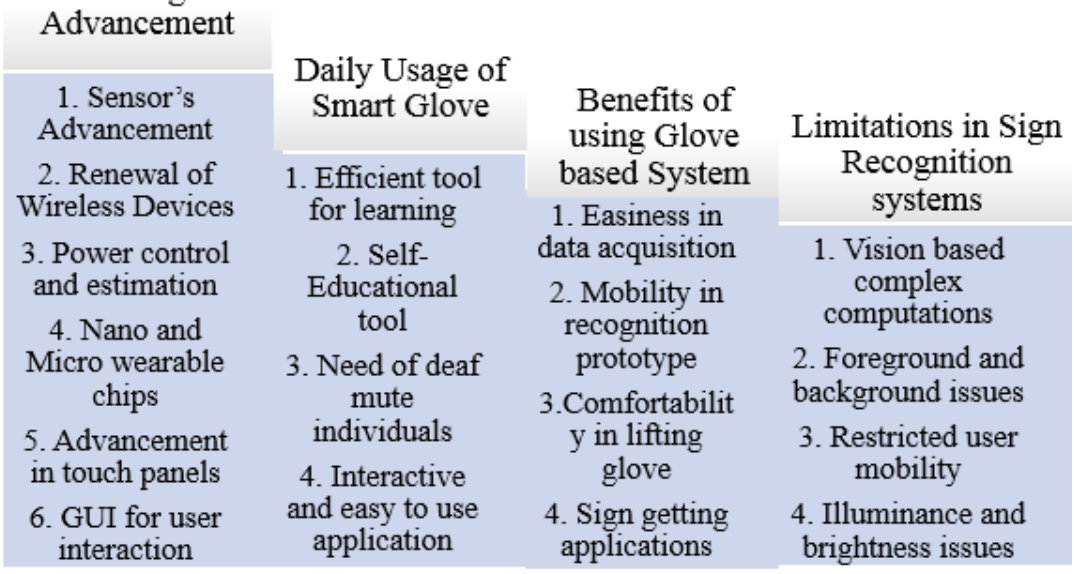
Figure 18. Overview of key points regarding motivational domains of sign language.